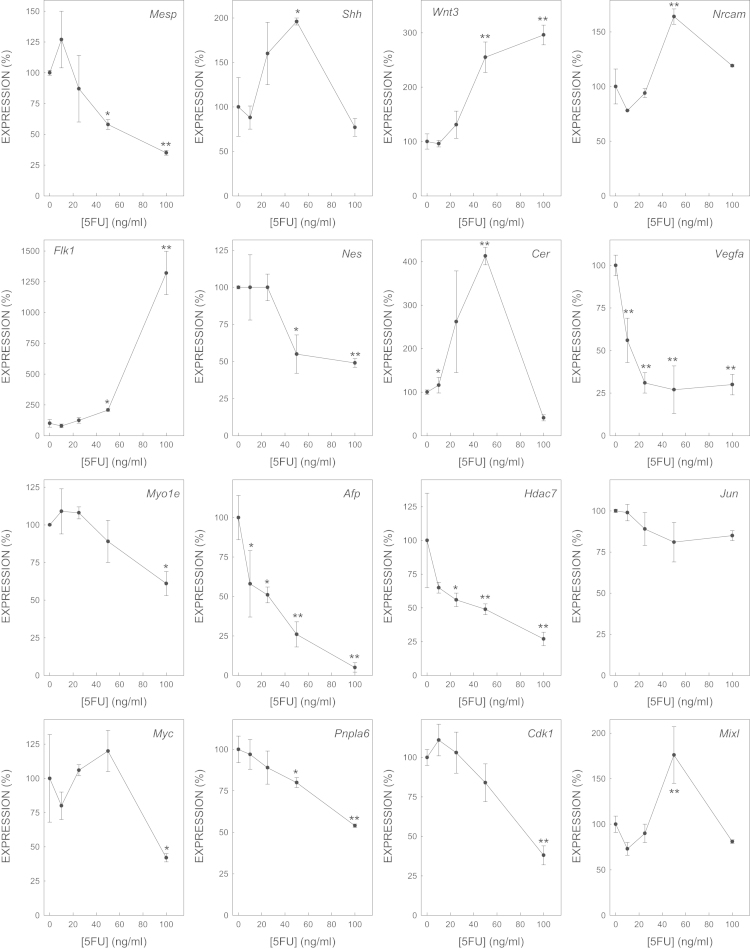
Effect of 5FU on the expression of biomarker genes.